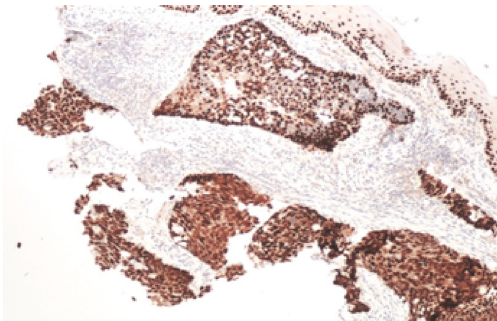
Figure 4: SCC positive for P63, CK 5/6, and CAM5.2.